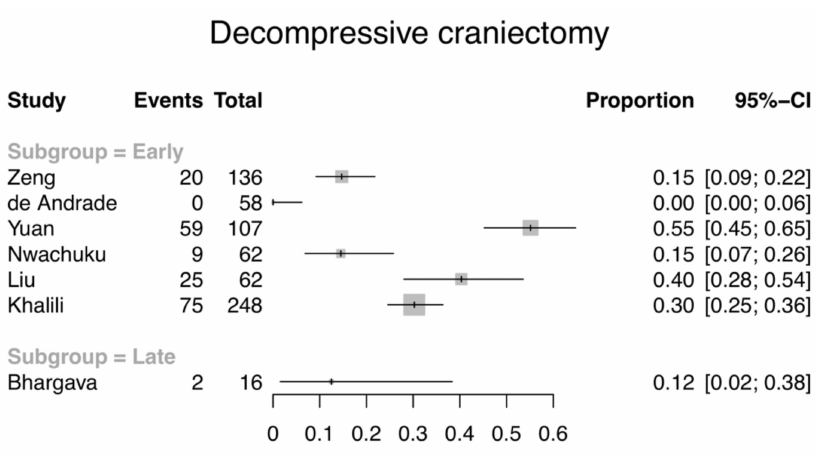
Figure 4. Forest plot illustrating the proportion and 95% CI of patients receiving decompressive craniectomy. All but one of the studies are in the early EVD